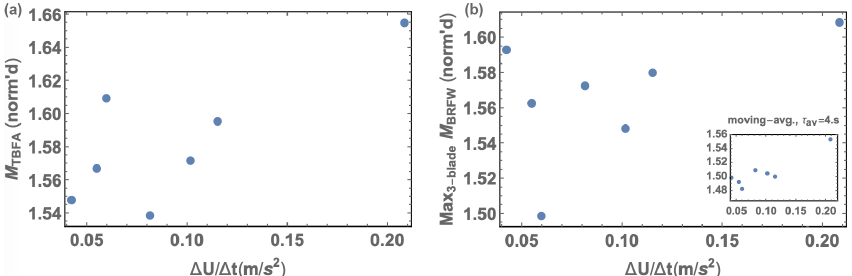
Figure 10. Tower-base fore–aft moment (a) and blade-root flap-wise bending moment (b) versus ramp acceleration, for ramp cases exceeding rated speed, from constrained Mann-turbulence (stand-alone) simulations. Loads normalized by mean values outside of ramp events, over all cases. Right inset shows same plot but with averaging time of τ av = 100 t s =